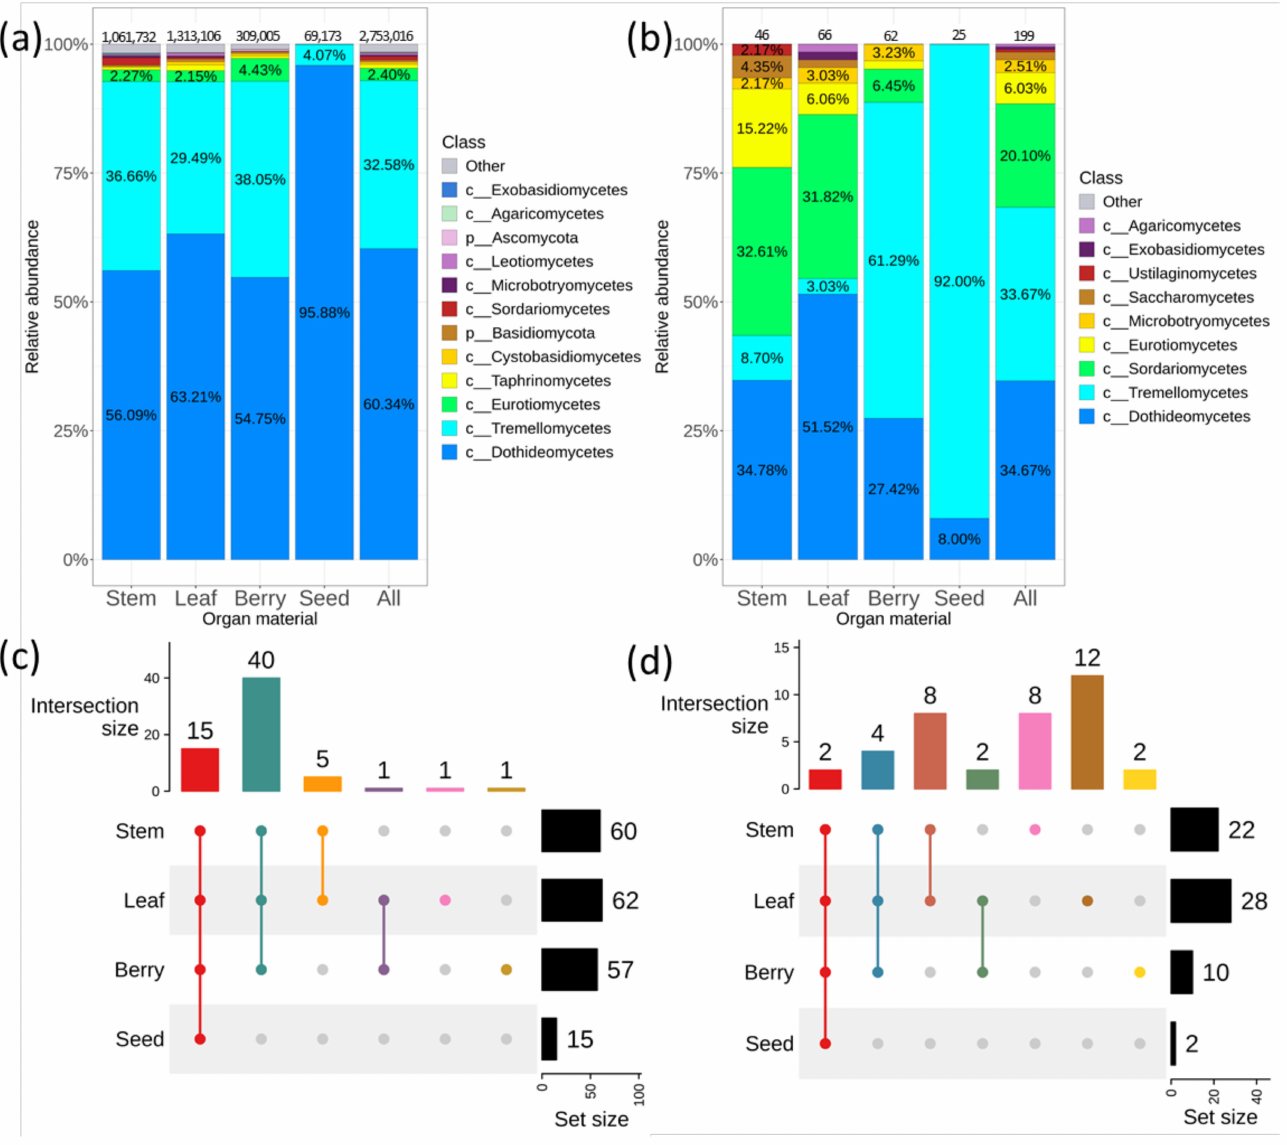
Figure 1. Comparative analysis of the fungal endophytic community composition in different organs of wild grape Vitis amurensis according to the cultivation-independent (next-generation sequencing (NGS)) and the cultivation-dependent (fungal sowing (Sow)) approaches. The composition of endophytic fungi of V. amurensis depends on the plant organ: ( a ) Class level taxonomical bar plots for the fungal endophytic community in stem, leaf, berry, seed, and the sum of data for all V. amurensis organs obtained using NGS; ( b ) Class level taxonomical bar plots for the fungal endophytic community in stem, leaf, berry, seed, and the sum of data for all V. amurensis organs obtained by fungal sowing; ( c ) Genus level UpSet diagrams depicting overlapping taxa of NGS in leaf, stem, berry, and seed; ( d ) Genus level UpSet diagrams depicting overlapping taxa of fungal sow in leaf, stem, berry, and seed. Taxa were filtered based on relative abundance of >0.1% for each biocompartment. Taxa of relative abundance of <0.1% were removed from UpSet diagram. Number of sequences or strains (for sow) are shown above taxonomical bar